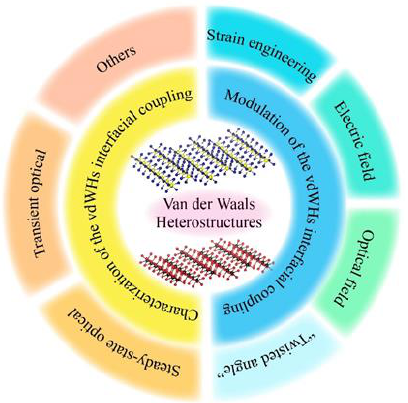
Figure 1. Schematic illustration of the main contents in this review.